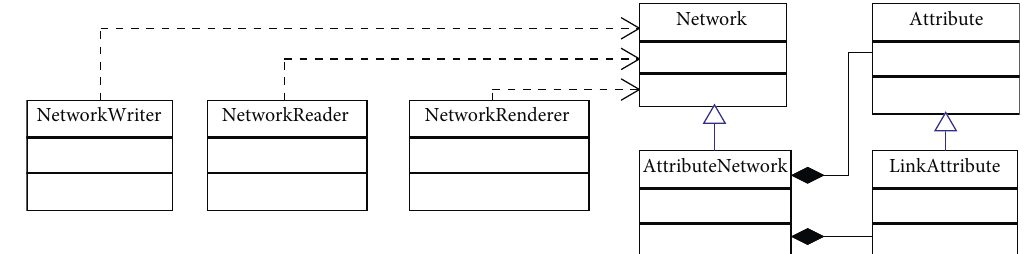
Figure 2: UML class diagram depicting some of the NOESIS core classes and